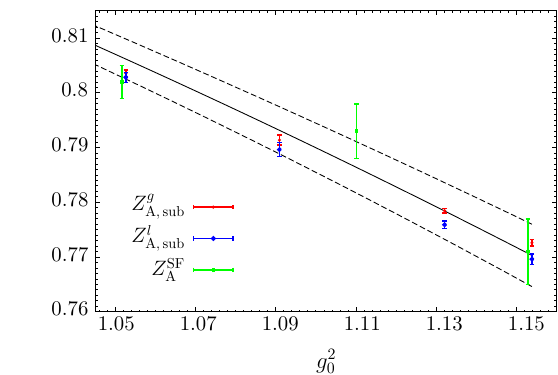
corresponds to the SF results from the fit formula of Ref. [8], and the dashed lines delimit the 1 σ region of the fit. Note that the SF fit for- mula is obtained by considering additional points with g 2 shown, and by enforcing the perturbative 1-loop behaviour for g 2 (see Ref. [8] for the details)